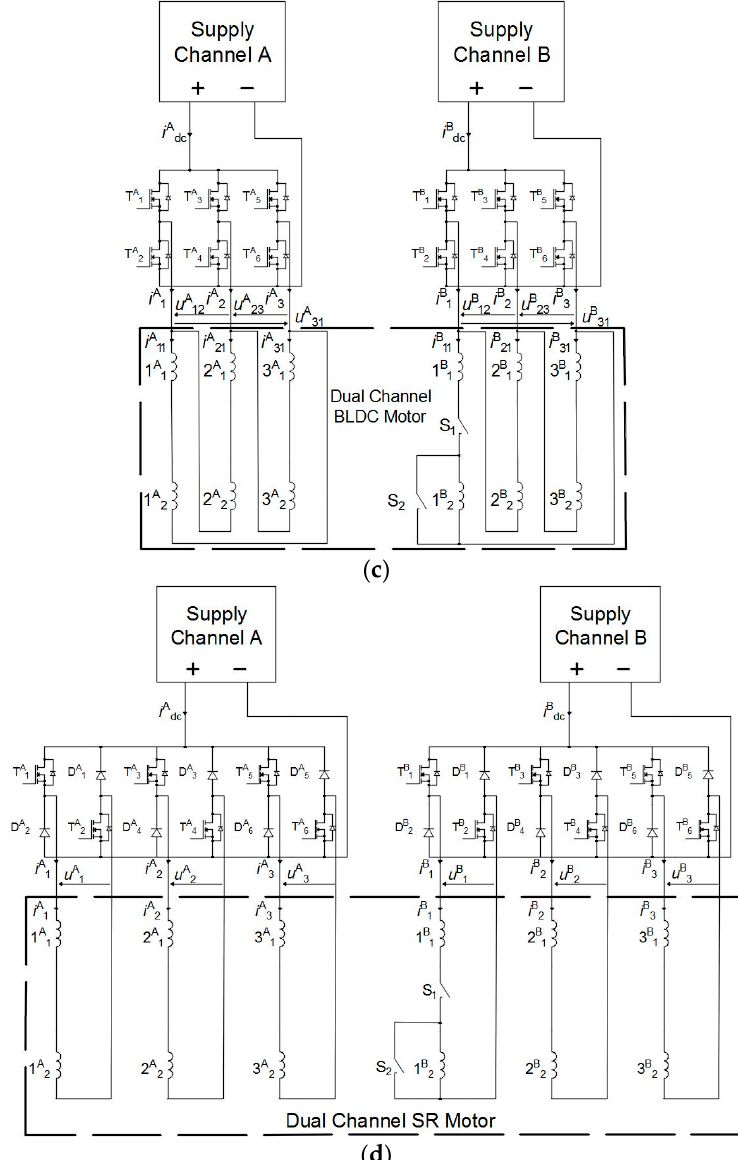
Figure 1. The geometry and prototypes of dual-channel power supplied brushless electronically commutated motors. (a) The geometry and prototype of a three-phase DCBLDCM. (b) The geometry and prototype of a DCSRM. (c) A scheme of a DCBLDC motor supply system in the DCO mode. (d) A scheme of a DCSRM supply system in the DCO mode. Table 1. Main parameters of the BLDC motor and the SRM for SCO modes.